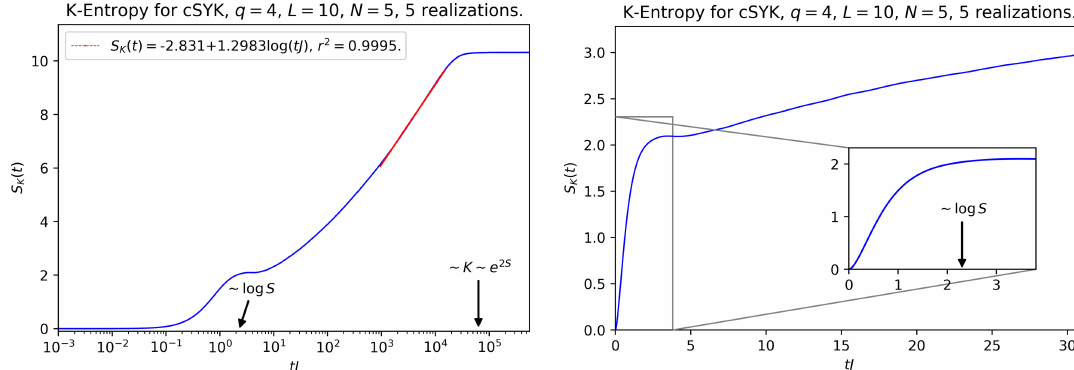
Figure 3 . K-entropy averaged over 5 random realizations with L = 10 sites at half filling. Left: full time range computed, with logarithmic scale along horizontal axis. A linear fit in the post- scrambling regime, where K-entropy is expected to grow logarithmically, is depicted in red. K- entropy grows linearly up to scrambling time, and then transitions to a logarithmic growth phase that continues until saturation around S at exponentially late times (this is the time K ∼ L ∼ S scale at which the wave-packet ϕ ( t ) becomes fully dispersed). Right: K-entropy at early times n with linear scale along the horizontal axis. The exact location of the time scales may depend on a dimensionful prefactor (see caption of figure